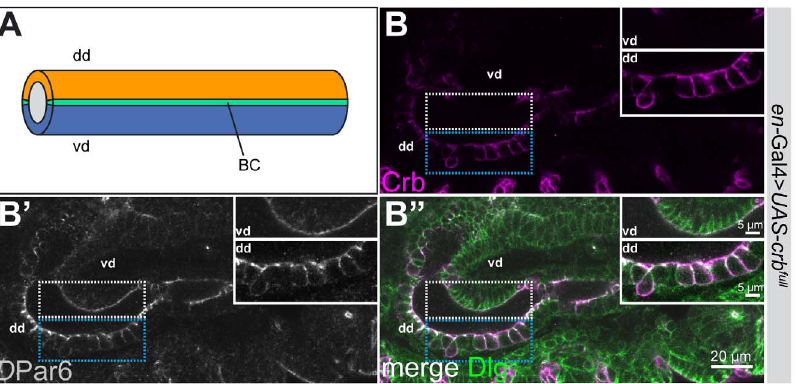
Figure 6. Crb overexpression in PCs leads to an expansion of the apical membrane domain. ( A ) Schematic representation of the large intestine with the dorsal domain (dd) in orange, the ventral domain (vd) in blue and the BCs in green. ( B–B 0 ) Confocal microscope images of a stage 15 embryonic hindgut expressing UAS-crb full under the control of en- GAL4 in the PCs of the dorsal domain. The hindgut is stained with anti-Crb (magenta), anti- D Par6 (grey) and anti-Dlg (green). The insets show higher magnifications of the vd (outlined by the grey dotted line), which serves as control tissue and the dd (outlined by the blue dotted line) where the altered apico-basal polarity in cells overexpressing Crb is highlighted (due to the very strong overexpression of Crb in the dd, the gain of the microscope was strongly reduced).